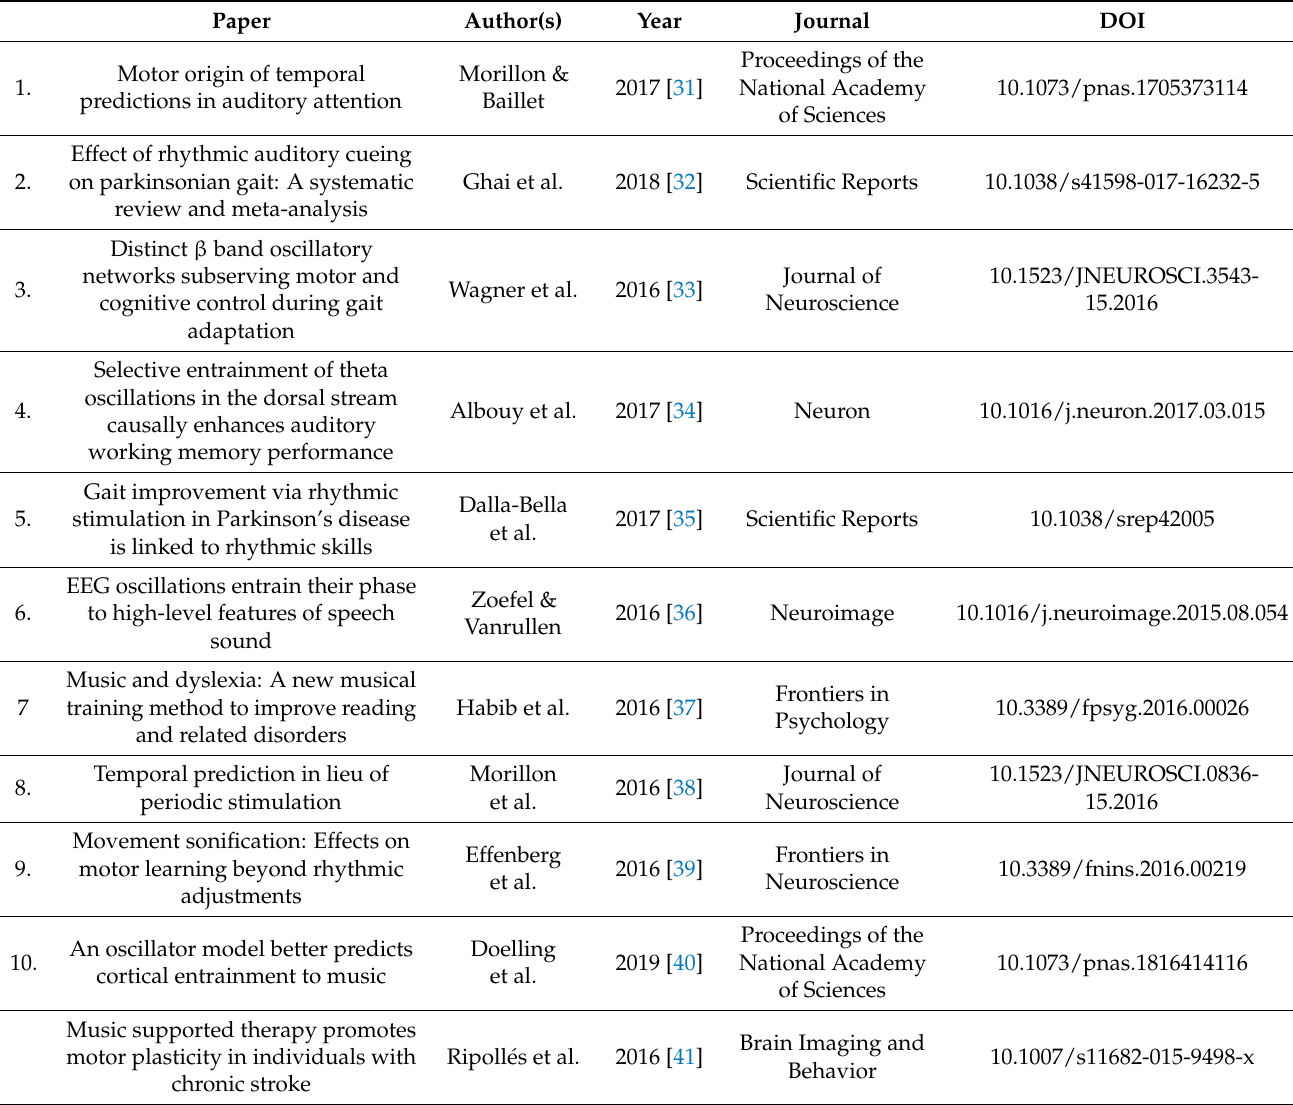
Table 5. The top 10 most-cited articles during